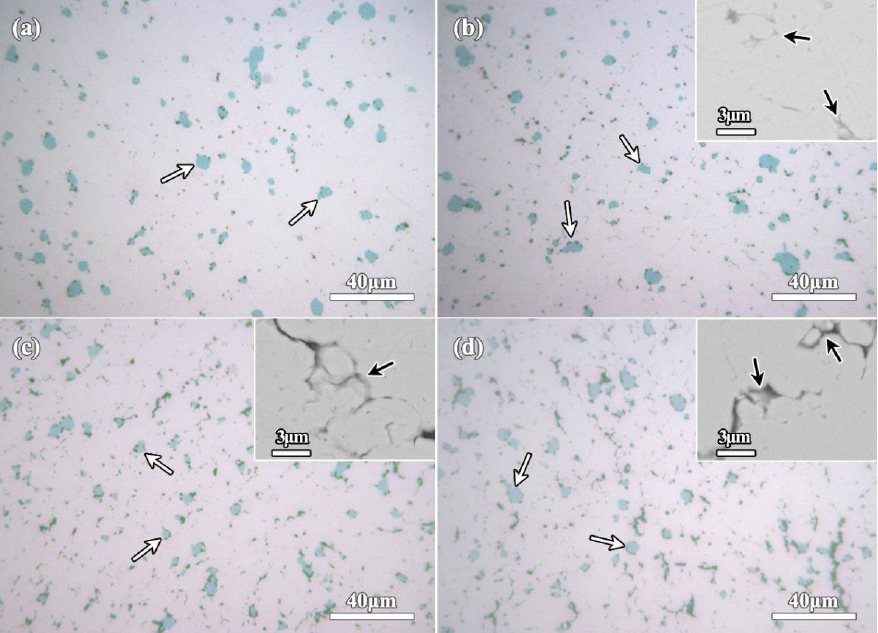
Figure 7. OM micrographs of the sintered compacts showing the dispersed Fe microspheres (marked by white arrows): ( a ) 0rGO, ( b ) 1rGO, ( c ) 2rGO, ( d ) 3rGO. The insets show BSE-SEM micrographs of rGO nanosheets agglomeration (marked by black arrows) in the sintered compacts.